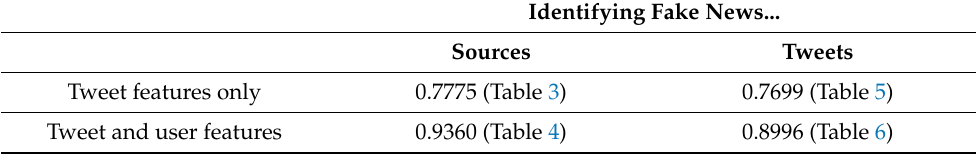
Table 7. Results summary, depicting the best F1 score achieved for each task (fake news source and fake news tweet detection), as well as for each feature group (tweet level features only and tweet and source